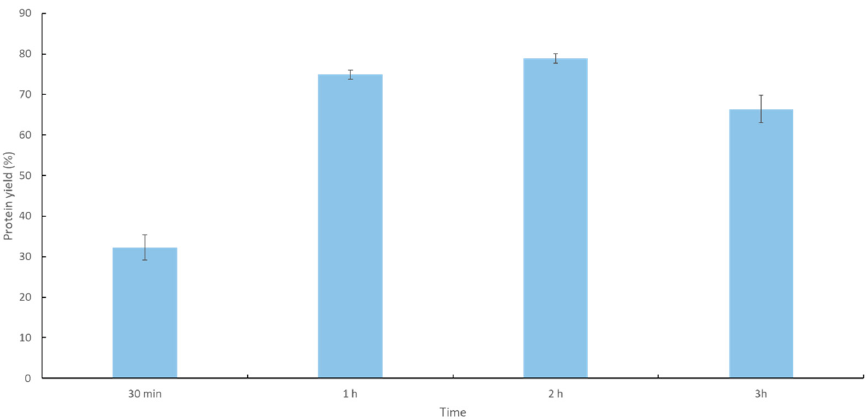
Figure 1. Effect of time on immobilization of YT PTE. The immobilization process was done at room temperature.